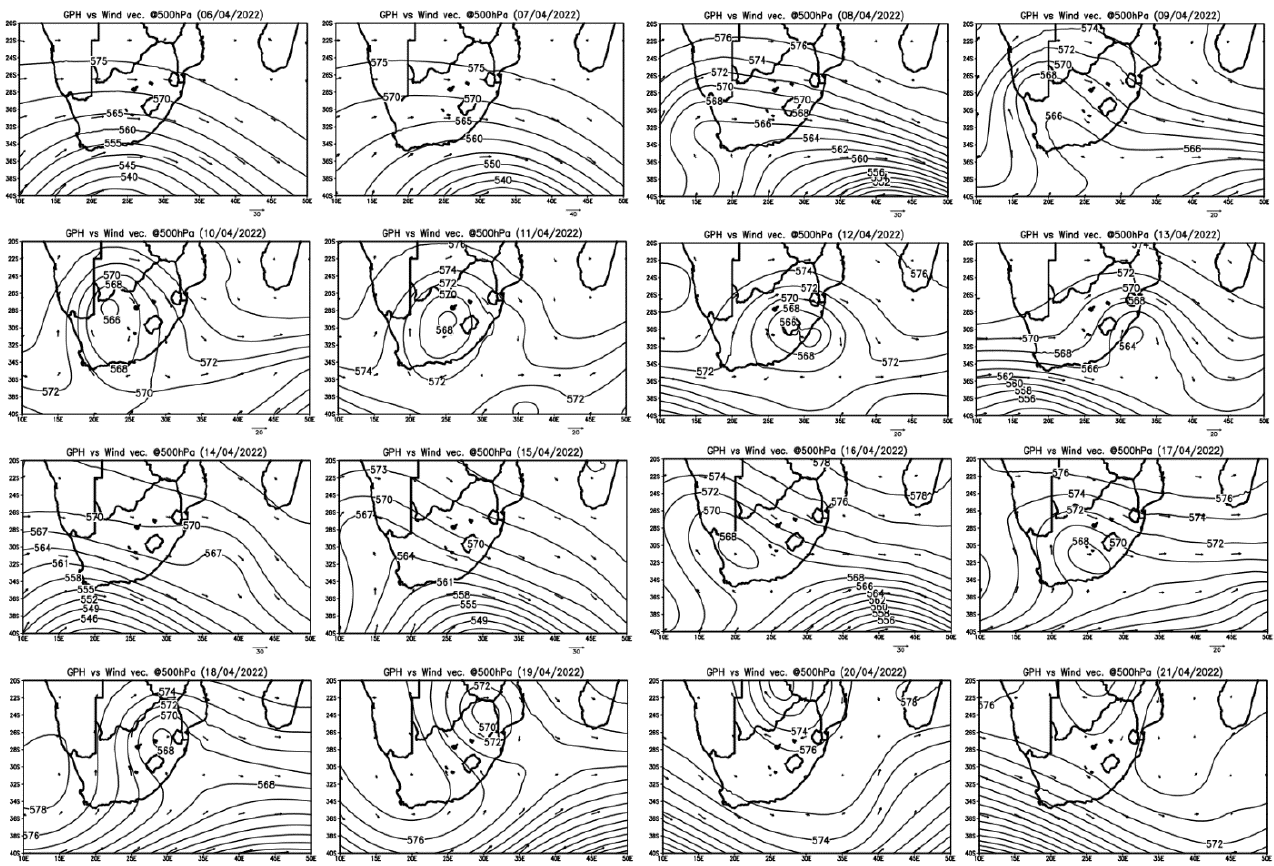
Figure 2. Geopotential heights (m) at 500 hPa showing the evolution of two COLs events during 6– 21 April 2022. April